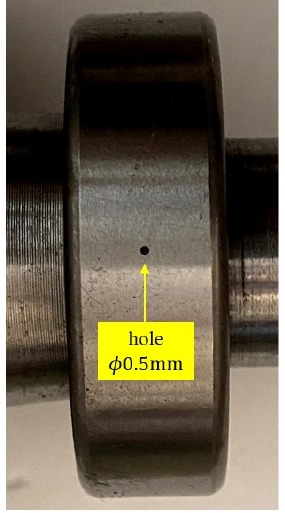
Figure 2. Production of bearing fault.